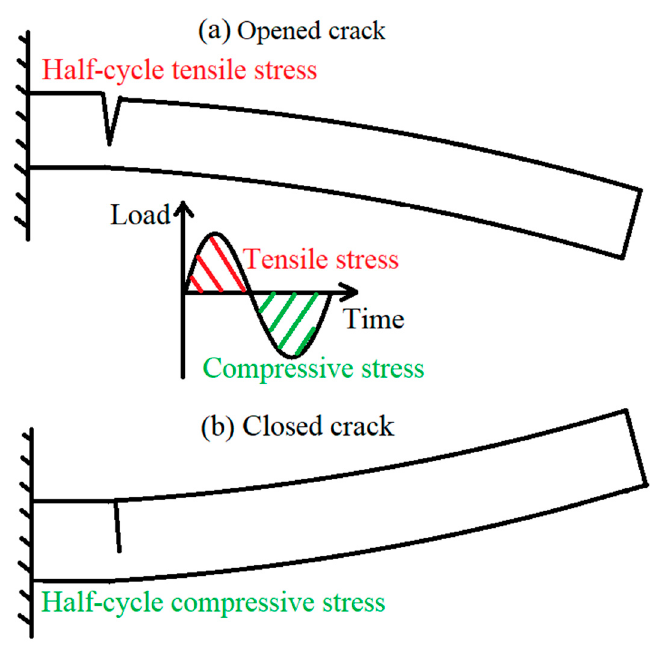
Figure 8. Load conditions during cyclic vibration.